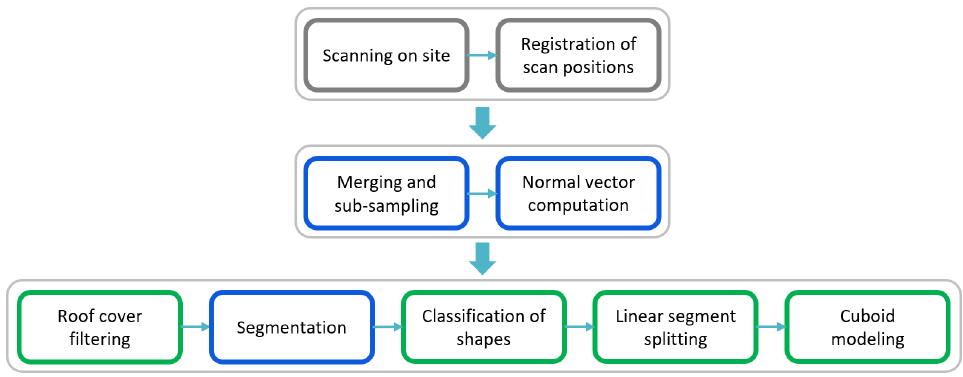
Figure 2. Main stages of the 3D modeling